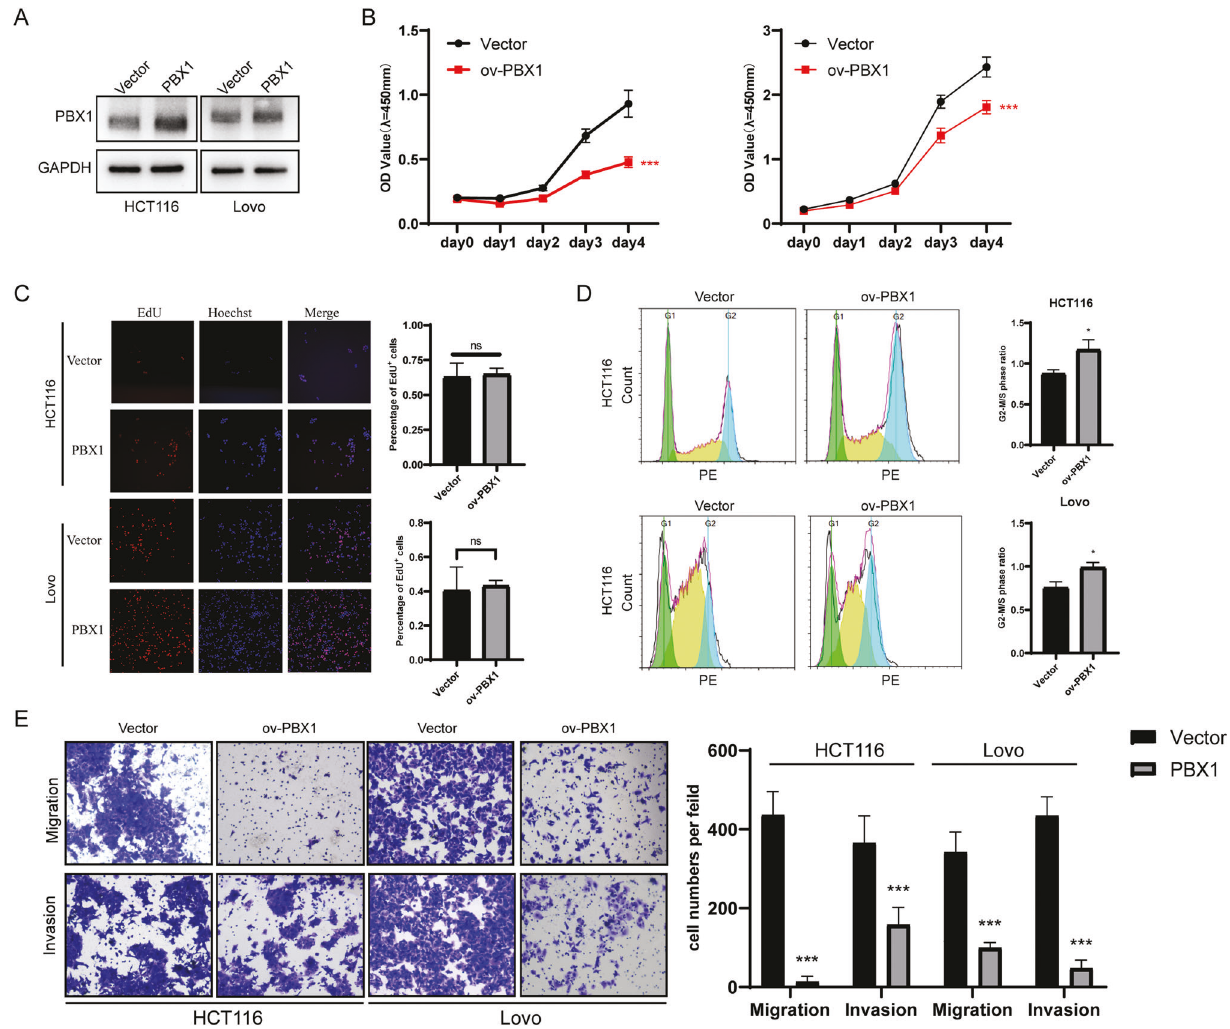
Fig. 2 PBX1 suppressed tumor proliferation and metastasis of CRC in vitro. A Western blotting con fi rmed the overexpression ef fi ciency of PBX1 in HCT116 and LoVo cells. B PBX1 reduced the proliferative ability of CRC cells as detected by the CCK-8 assay. C EdU assay revealed